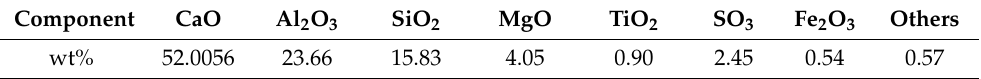
Table 1. Chemical composition of raw slag as determined by XRF